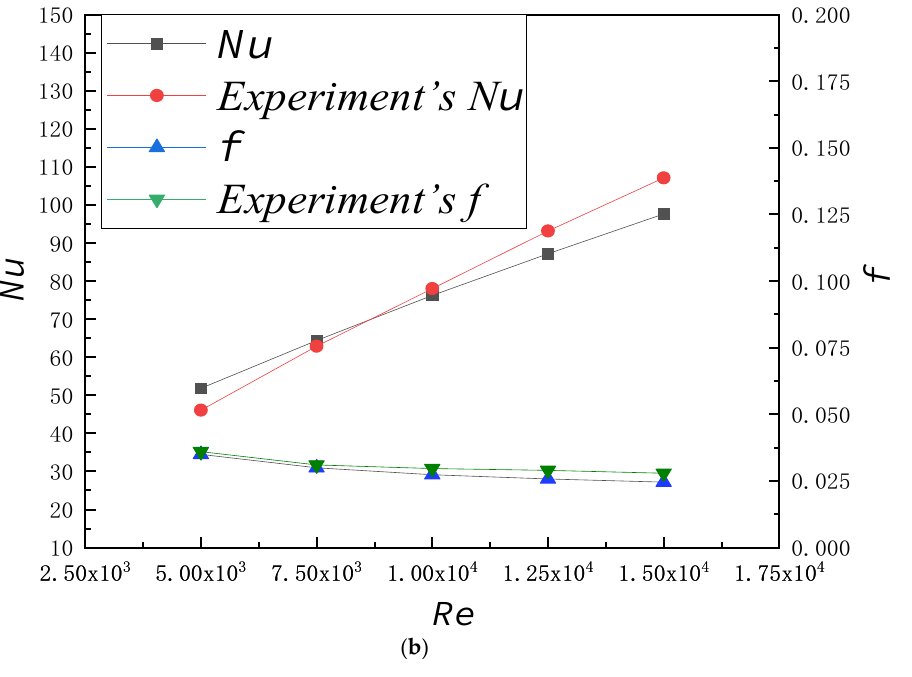
Figure 4. Verifications: ( a ) Numerical results vs. Correlation data; ( b ) Numerical results vs. Experi- mental results.